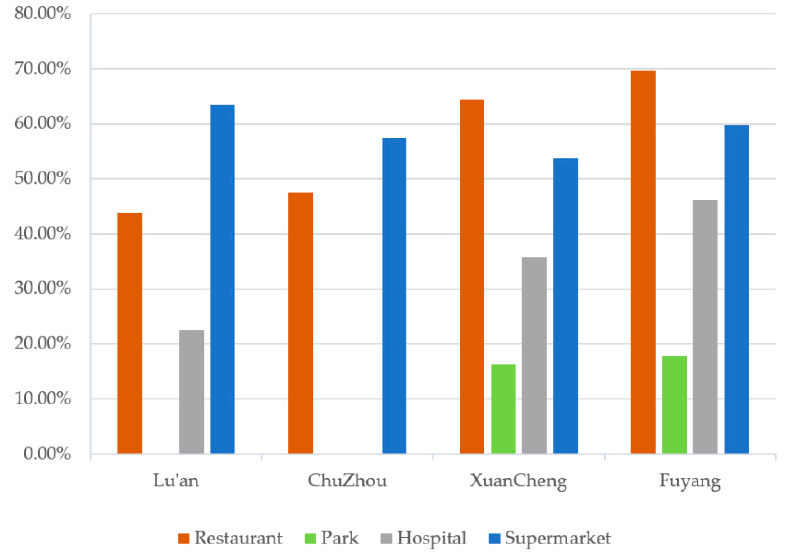
Figure 1. Proportions of people with restaurants, parks, hospitals and supermarkets within an 800 m buffer by city (%).